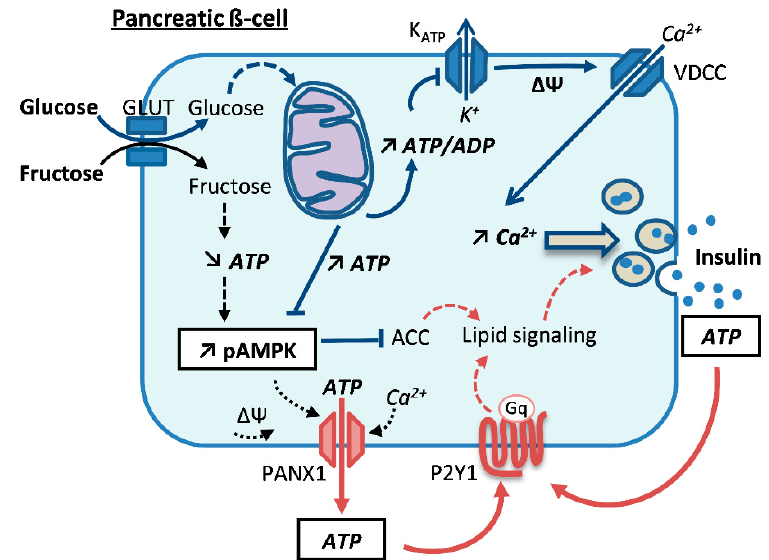
Figure 1. Regulation of insulin secretion by the pancreatic β -cell and intracellular / extracellular ATP signaling pathways. Glucose metabolism leads to the production of ATP in mitochondria. The ensuing elevation of the ATP / ADP ratio induces the closure of the K-ATP channels, which promotes the depolarization of the plasma membrane that opens the voltage-sensitive calcium channels. The resulting elevation of cytosolic calcium concentration triggers insulin release (blue arrows). Prolonged treatment with fructose induces a fasting-like phenotype in β -cells, resulting in AMPK activation even in the presence of glucose (black arrows). Fructose exposure activates Panx1 channels, promoting the release of cellular ATP and activation of purinergic P2Y1 receptors on the plasma membrane (red arrows). Chronic fructose exposure potentiates the stimulation of insulin secretion at intermediate glucose concentrations. Therefore, intracellular and extracellular ATP signaling pathways could play a concerted role in the β -cell as potentiators of glucose-induced insulin